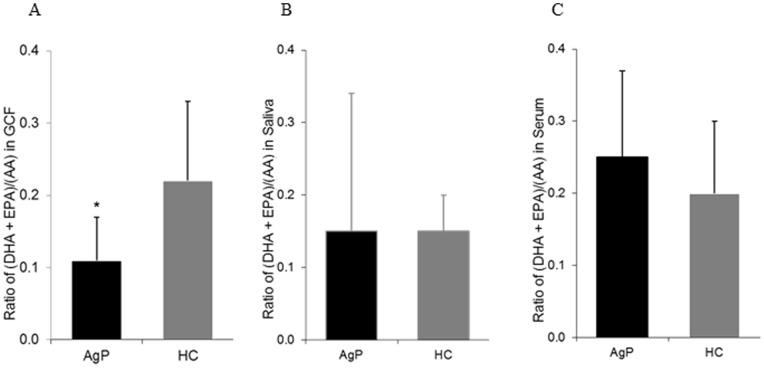
Ratio of n3- to n6-PUFAs in gingival crevicular fluid (GCF) (A), saliva (B) and serum (C) samples.The figure shows the ratios of concentration of (EPA plus DHA) vs. AA in respective fluids of aggressive periodontitis patients (AgP, black bar) and healthy controls (HC, grey bar). * = P<0.05 by use of Mann-Whitney test.